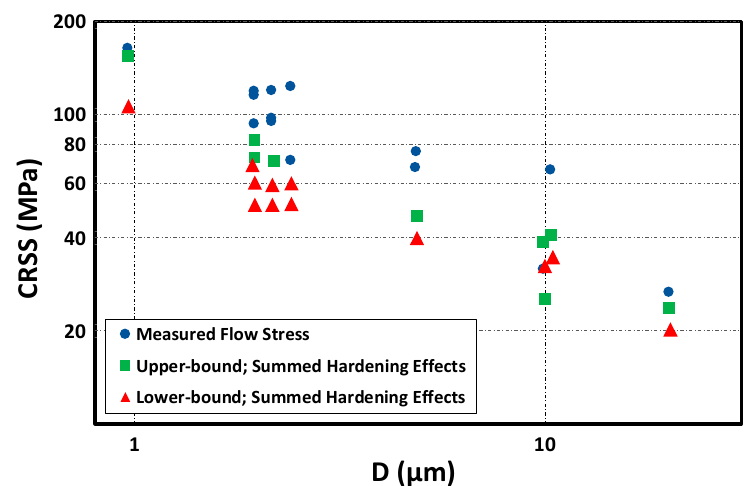
Figure 11. A comparison between the lower and upper bounds of Equation (9) with the experimentally measured proportional limits of Ni micropillars (after Norfleet et al. [56]).